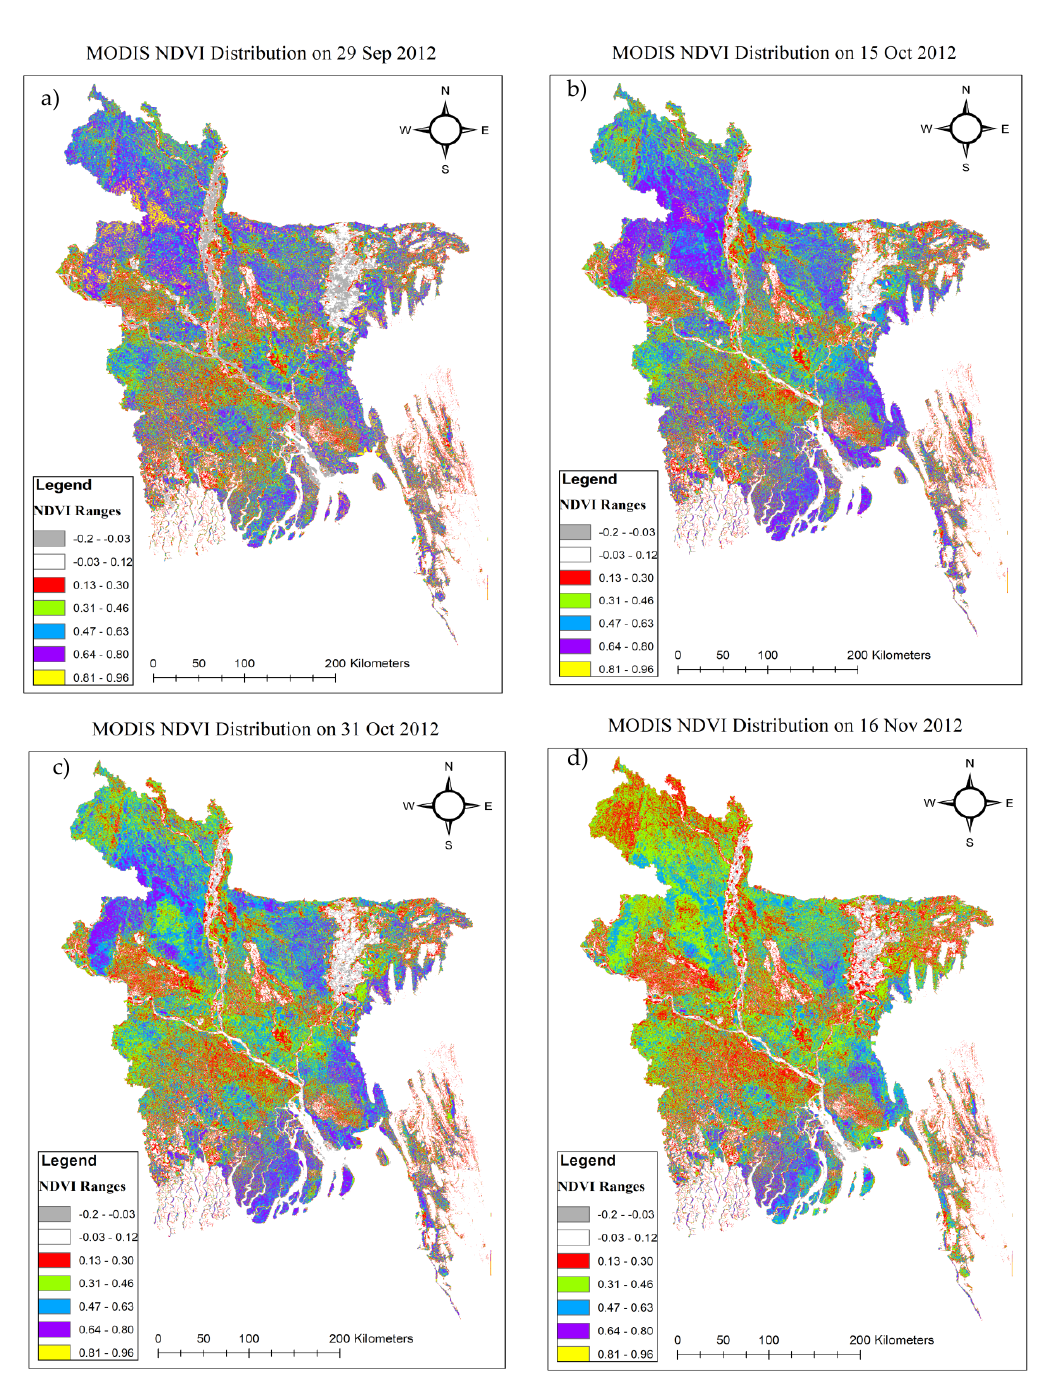
Figure 2. ( a – d ): Phenological changes of crops based on MODIS NDVI distribution at different dates in a year (2012).